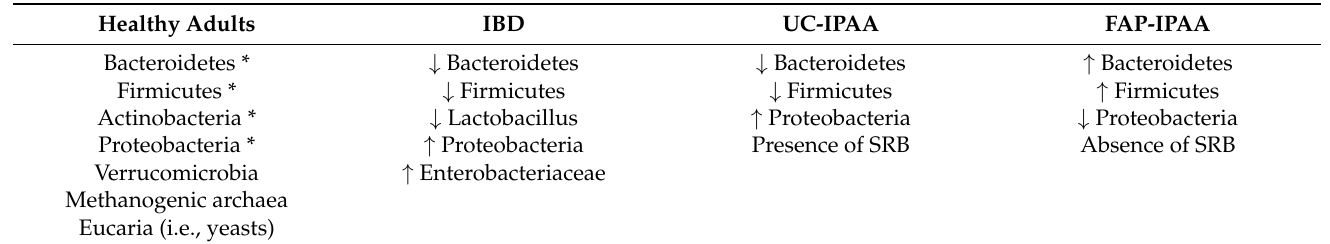
Table 1. Most common microorganisms and main differences between healthy adults, IBD patients, UC-IPAA, and FAP-IPAA